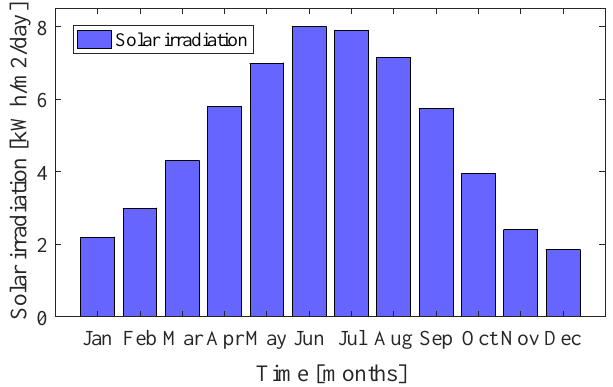
Figure 4. Yearly solar resource in Kea,